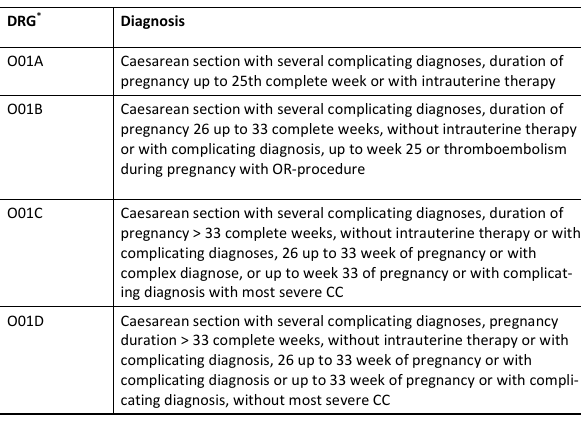
Table S2: Diagnosis Related Group codes used to identify women in Helsana health insurance data (INS), who gave birth in Switzerland 2012–2013, or were perinatal in